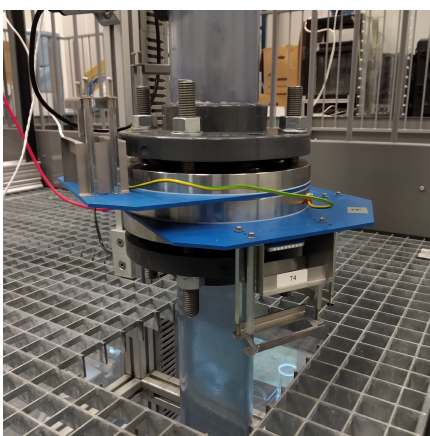
Figure 8. Double-layer wire-mesh sensor installed in the Flow Facility of the Delft University of